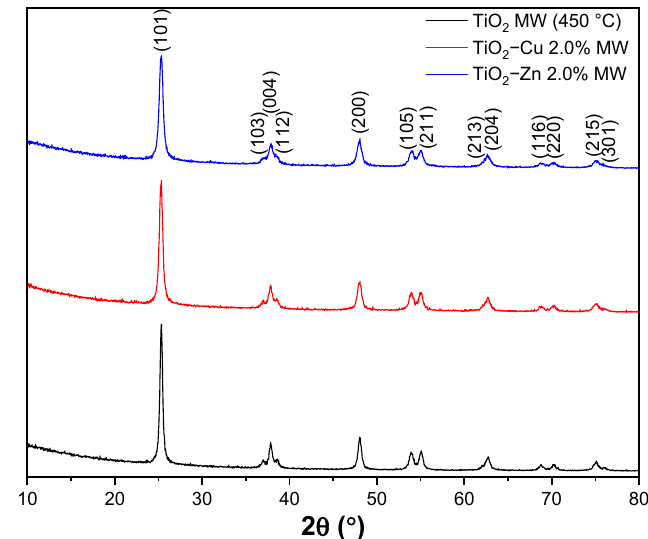
Figure 8. X–ray diffraction patterns of microwave-assisted sol–gel prepared samples, thermally treated (bottom—undoped TiO 2 sample, middle—Cu-doped TiO 2 sample, and top—Zn-doped TiO 2 sample). Table 3. The lattice parameters, the estimated crystallite size, and the average microstrain of the samples.